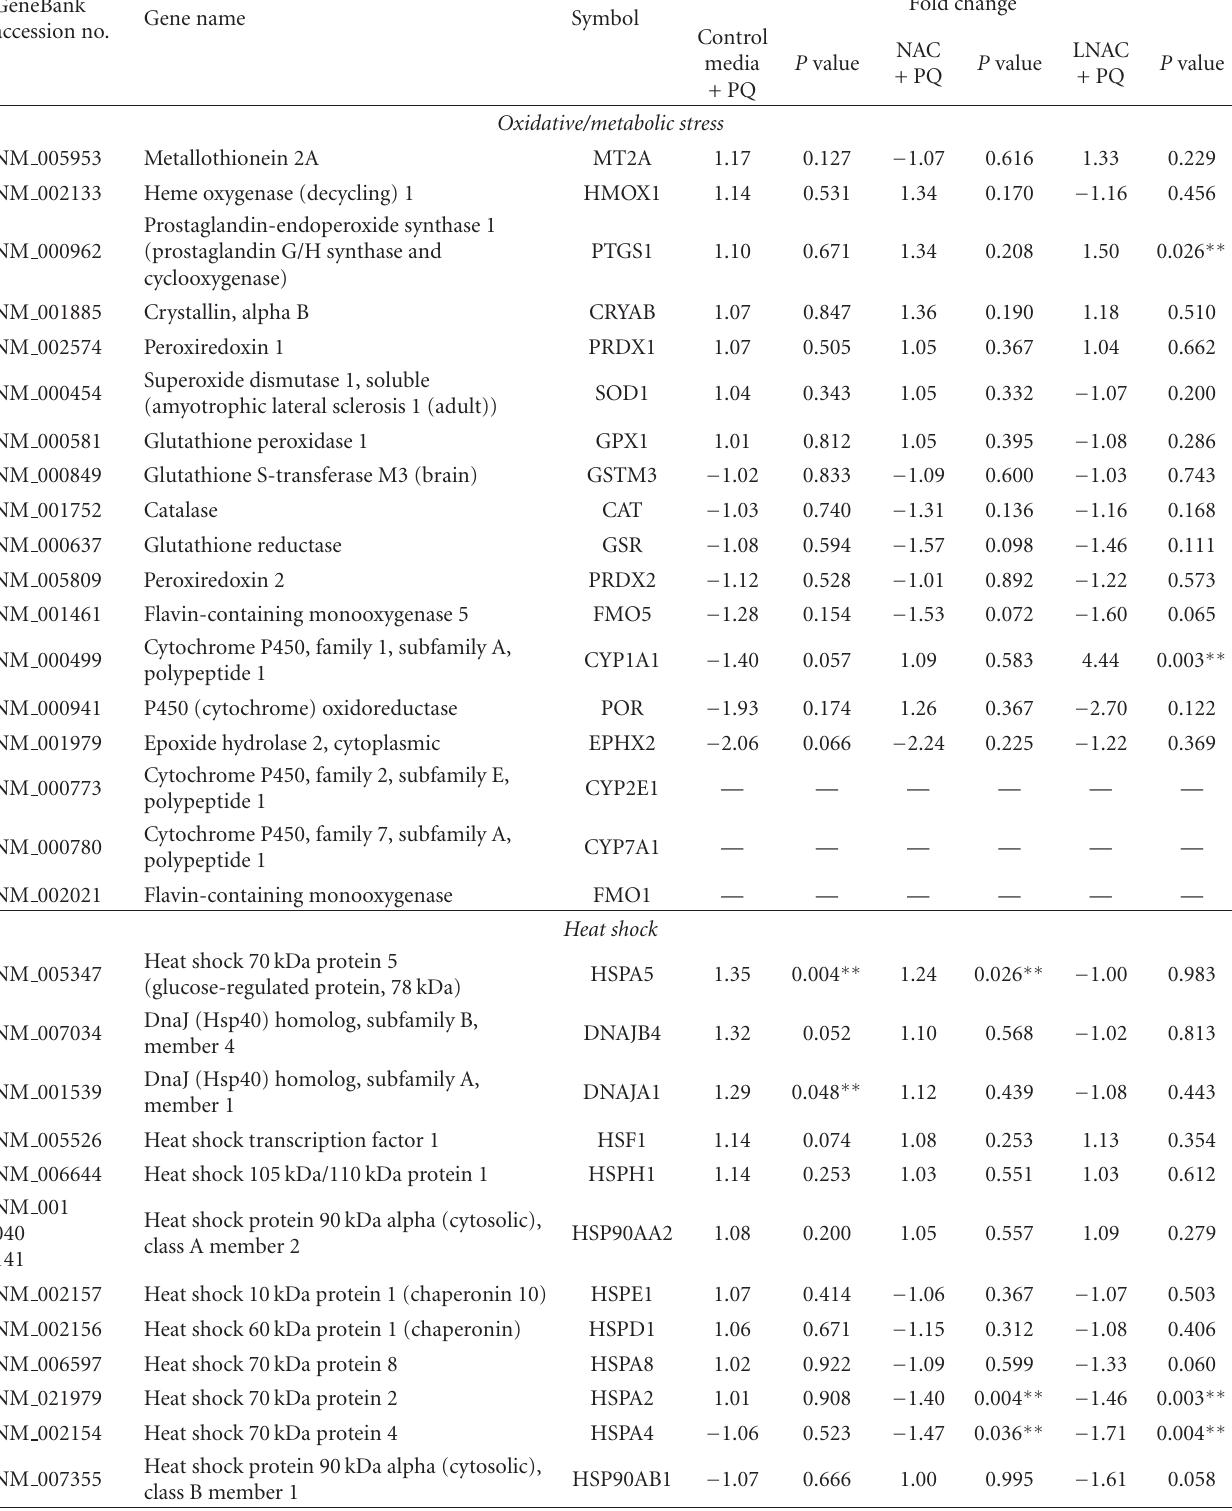
Table 1: Relative expression, via microarray analysis, of genes involved with cellular stress and toxicity in cells challenged with 0.25 mM PQ for 4h following pretreatment with control, NAC-containing, or L-NAC-containing media. Genes are listed in order of decreasing fold change in cells pretreated with control media and challenged with PQ. Fold change is expressed relative to untreated control cells using the housekeeping genes B2M, HPRT1, RPL13A, and GAPDH. Note . the proposed housekeeping gene ACTB was significantly altered following PQ challenge, and was not used in this capacity in our study. n = 3 independent